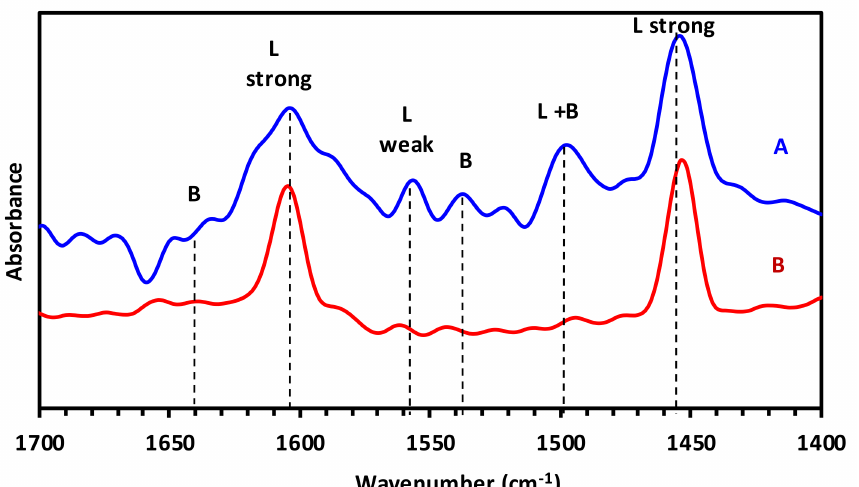
Figure 4. FT-IR spectra of pyridine adsorbed at 150 ◦ C on A: Sn-deAl-1.8-Beta-B; B: Sn-deAl-7.2- Beta-B. L and B indicate peaks corresponding to Brønsted and Lewis acid sites, respectively. More specifically: the signals at 1450 and 1611 cm − 1 are ascribed to pyridine adsorbed on strong Lewis acid sites; the signal at 1560 cm − 1 is attributed to pyridine adsorbed on weak Lewis acid sites; the band centered at 1500 cm − 1 stems from both Brønsted and Lewis acid sites; the weak signals at 1540 and 1649 cm − 1 are assigned to protonated pyridine on Brønsted acid sites